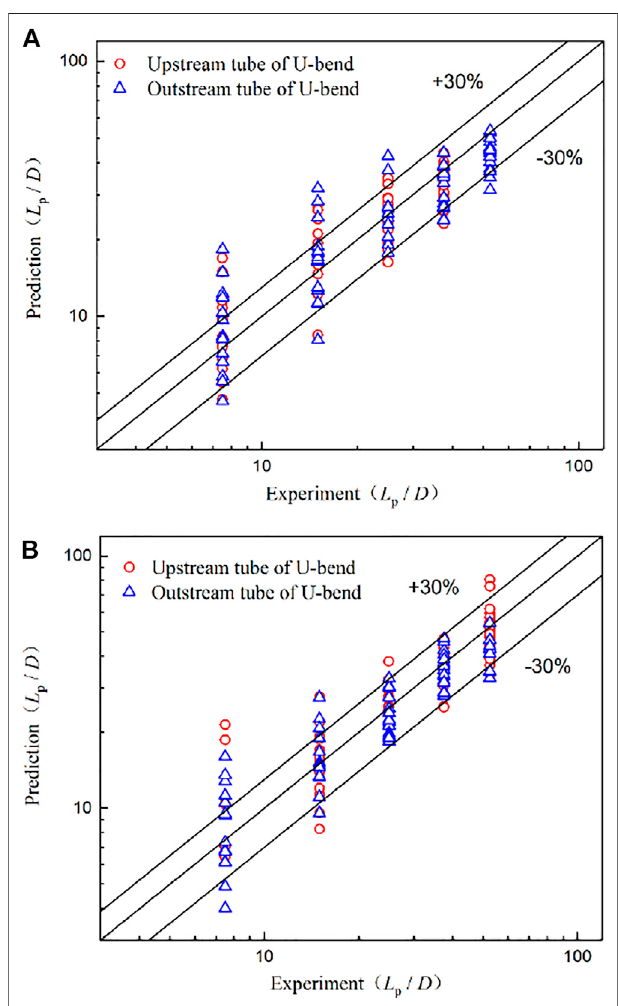
FIGURE 11 | Comparisons of the dimensionless perturbation length betweenmeasurementsandpredictions. (A) Downwardoriented fl owand (B) upward oriented fl